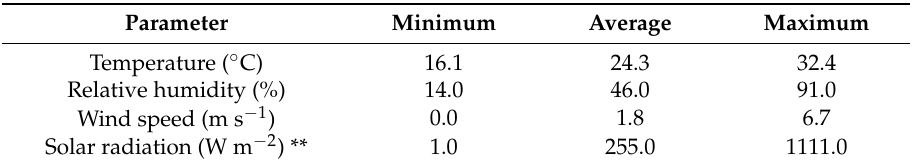
Table 1. Meteorological conditions in the GMA during the warm-dry